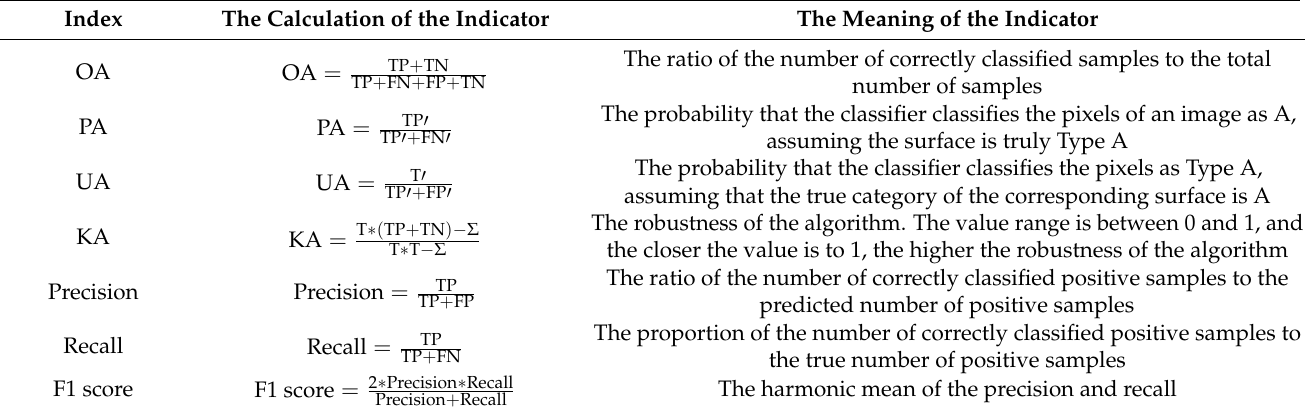
Table 4. The meaning of the indices used to assess accuracy. Note that the parameters used in calculation are explained.